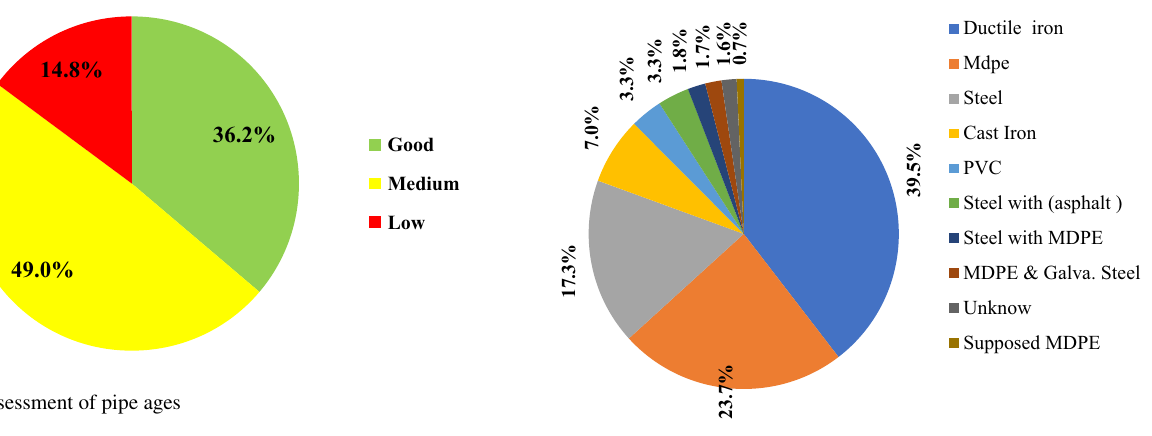
Fig. 6 Pipes materials of the Goma Township's water supply network